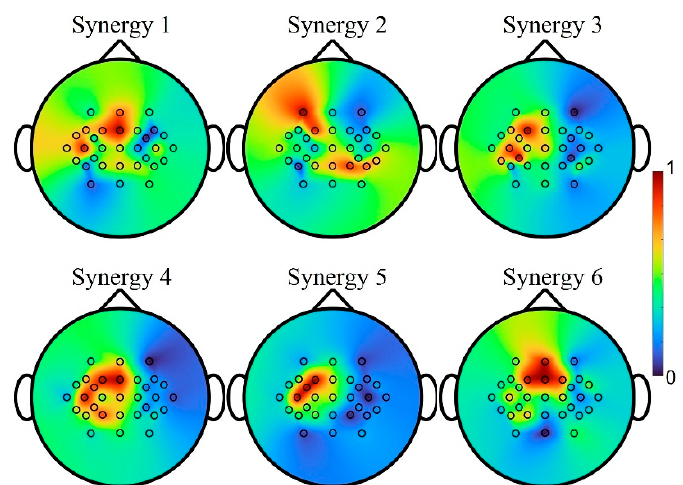
Figure 9. Spatial correlations of each synergy reflected on the scalp tomograph for Subject 2. The hand synergies are highly modulated on the central and left hemisphere, covering the areas of movement intention and motion-related activation generation. Synergies 1 to 5 were effective spatially with respect to hand area, and span across the premotor cortex, primary motor cortex and primary sensorimotor cortex. Synergies 1, 4 and 6 were mainly activated on the primary motor area and supplementary motor area. The primary motor cortex and the primary somatosensory cortex were activated on the contralateral hemisphere, as observed from Synergies 1, 3 and 4.